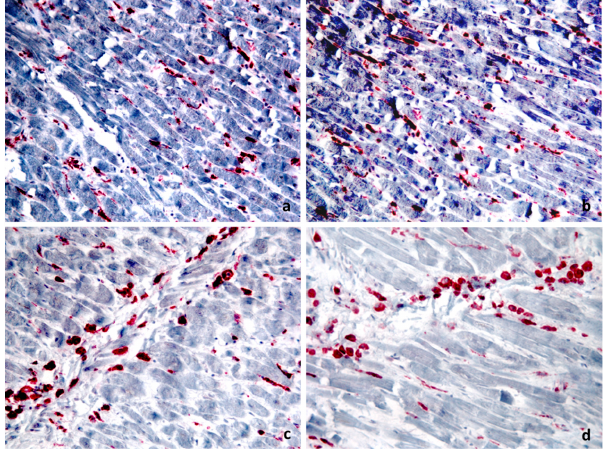
Figure 3. Sections from the same paraffin block of the heart demonstrate positivity for CD68 of the neoplastic elements (( a ) ×20 magnification) and for lysozyme (( b ) ×20 magnification). Sections from the same paraffin block but from different fields show the cytological details of the neoplastic cells for CD68 (( c ) ×40 magnification) and for lysozyme (( d ) ×40 magnification) (alkaline phospha- tase/RED system).